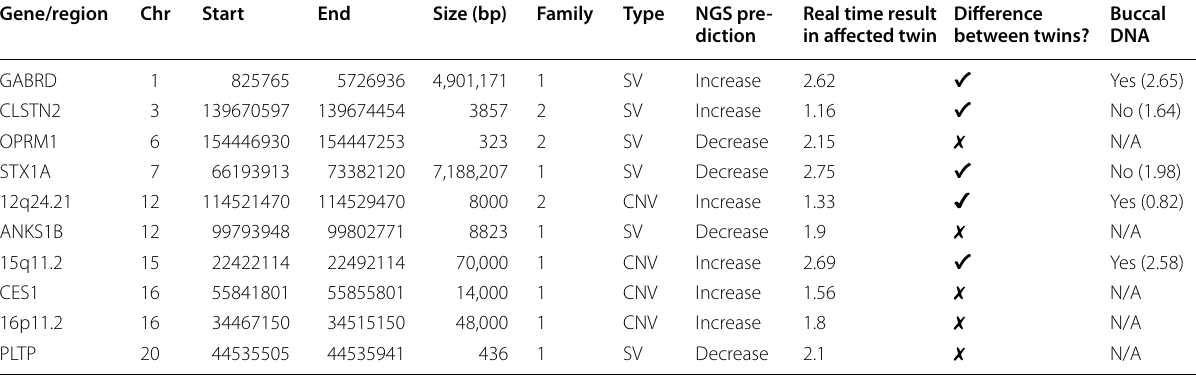
Table 9 Results of real time quantitative PCR analysis on 10 CNV/SV regions predicted by NGS to be unshared between twins Gene/region